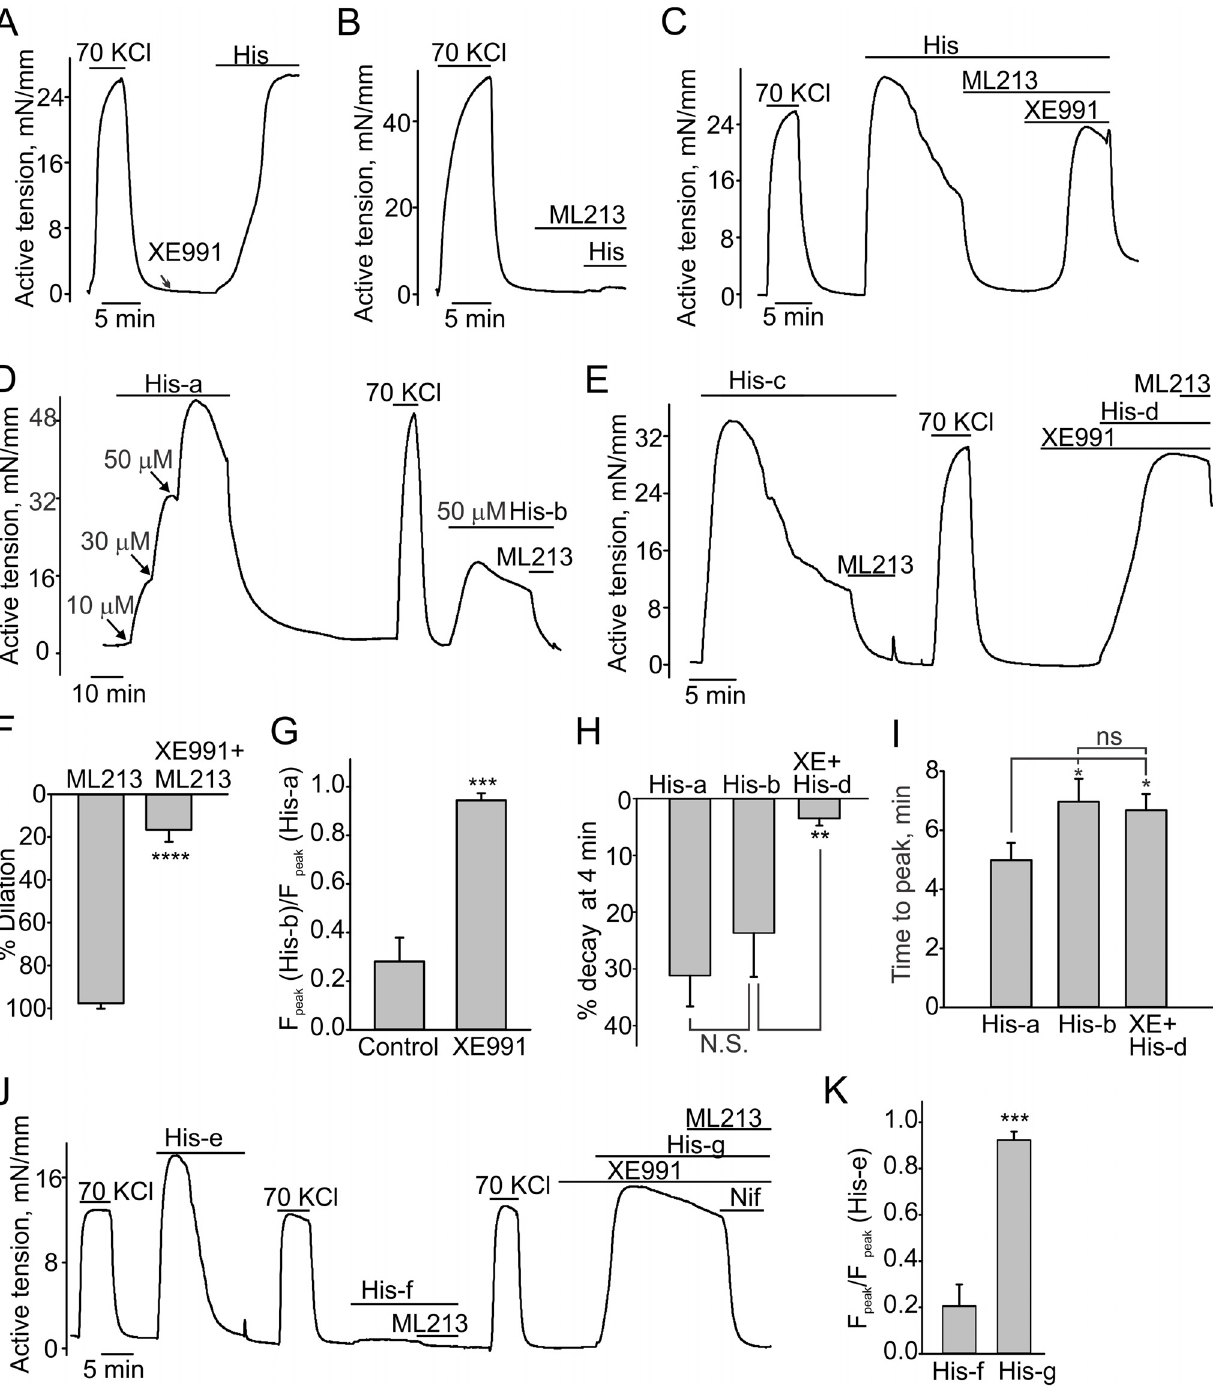
Fig 1. Effects of K v 7 modulators on pig CAs. Sample isometric tension measurement traces and statistical analysis data are shown. 70 mM KCl-induced contractions were regularly assessed to monitor the general reactivity of the tested CA rings. Neither 10 μ M XE991 ( A, n = 6) nor 10 μ M ML213 ( B, n = 6) affected the 2 – 3 g preloaded CA ring tension. C , 10 μ M ML213 potently dilated the pig CA pre-contracted with histamine (50 μ M), whereas XE991 (10 μ M) reversed the dilatory effect of ML213 (n = 4). D . Histamine concentration-dependently induced CA contractions. The shown isometric tension recording represents a time-matched control for “ E. ” The second histamine application induced a contractions with a smaller amplitude and slower onset kinetics (n = 4). E shows that the histamine-induced contractions exhibit slower kinetics of decay in the presence of 10 μ M XE991 (n = 8). F, Comparison of 10 μ M ML213-induced dilations of histamine-pre-contracted CA rings in the presence and the absence of 10 μ M XE991. G. Comparison of normalized forces of contractions (F peak ) in the presence and absence of 10 μ M XE991 (summary data for “ D ” and “ E ” ). The maximal force of the second histamine-induced